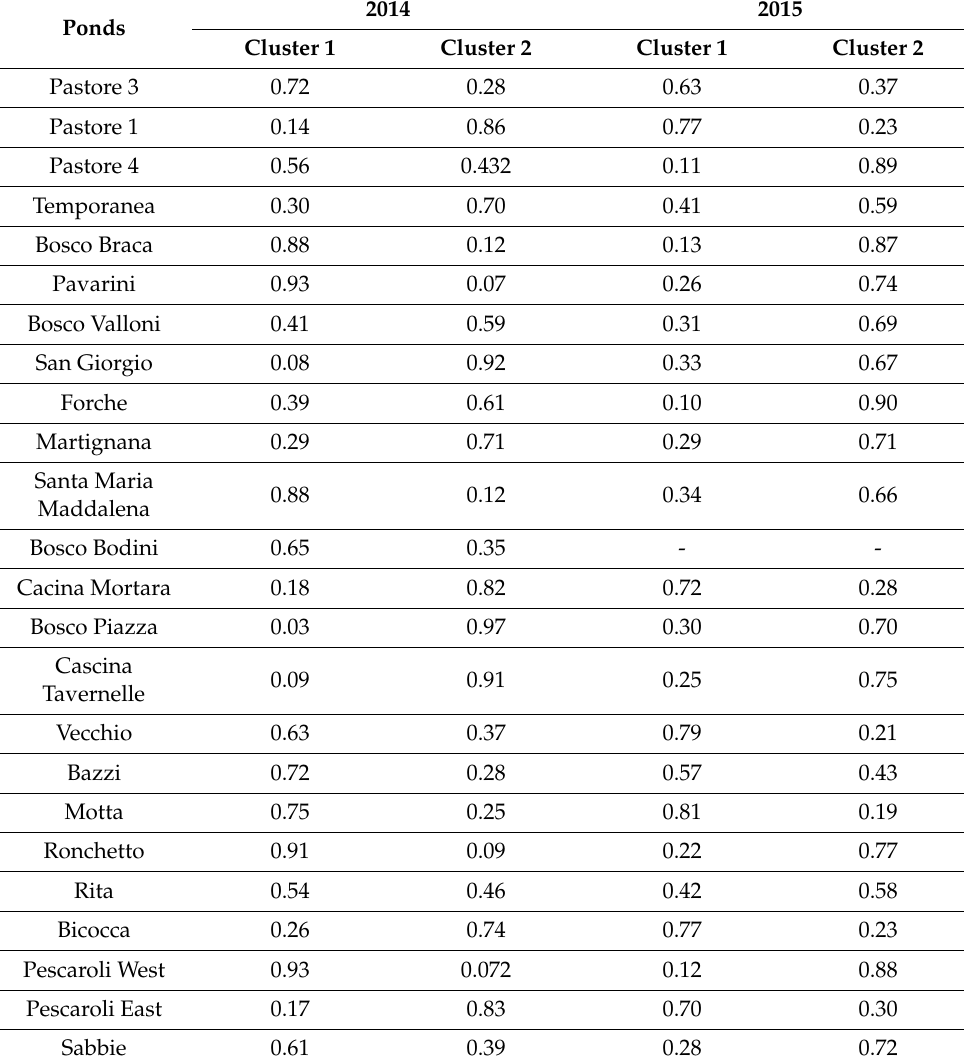
Table 2. Freshwater pond’s membership for each cluster in the year 2014 and 2015.